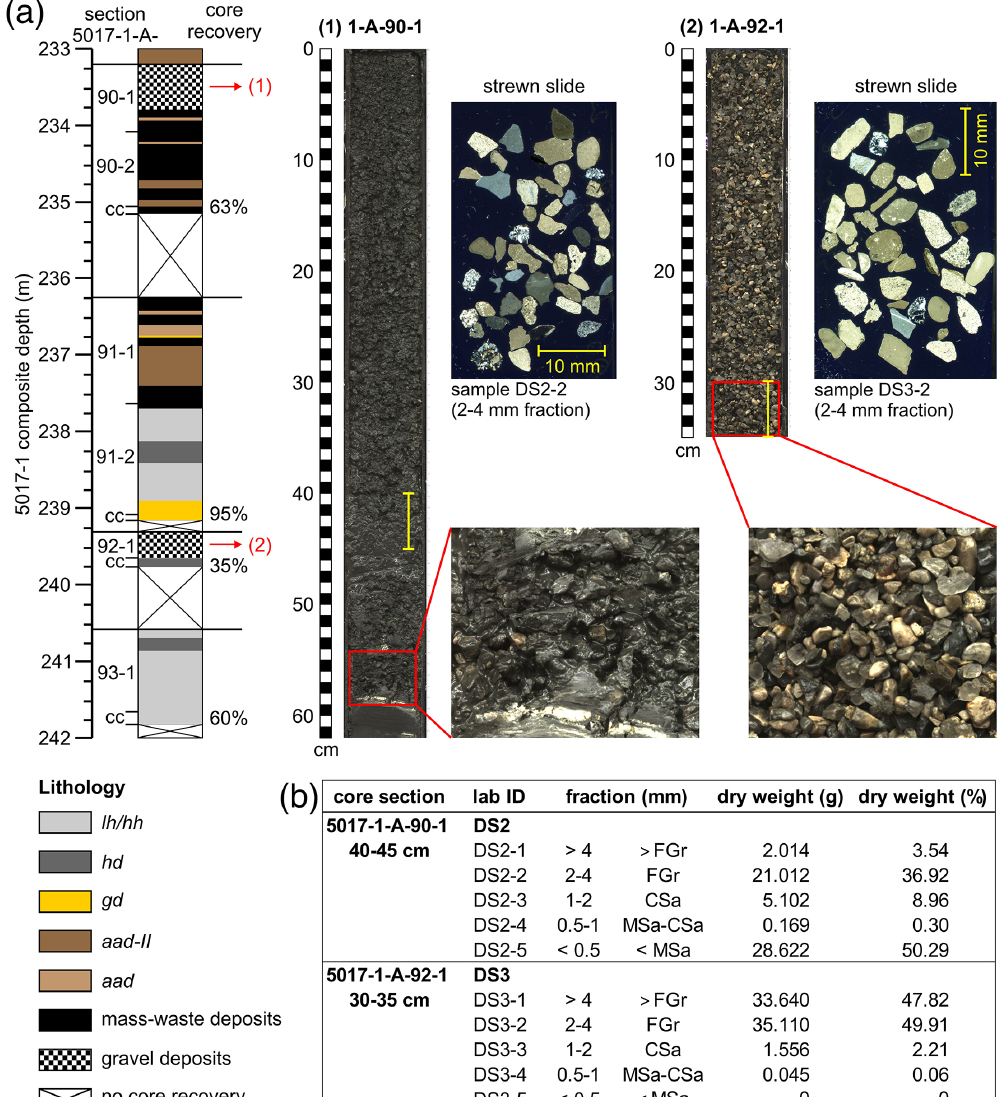
Figure 3. (a) Lithological profile from 233 to 242m composite depth (cc – core catcher), two gravel deposits in core sections (1) 5017-1- A-90-1 (233.17m composite depth) and (2) 5017-1-A-92-1 (239.27m composite depth) and strewn thin slide scans (polarised light) of the 2-4mm grain fractions; yellow bars indicate sampling positions in the two core sections. (b) Table of grain size fractions after sieving for one example of a mud-supported gravel occurrence and the pure gravel layer, both as shown in (a)